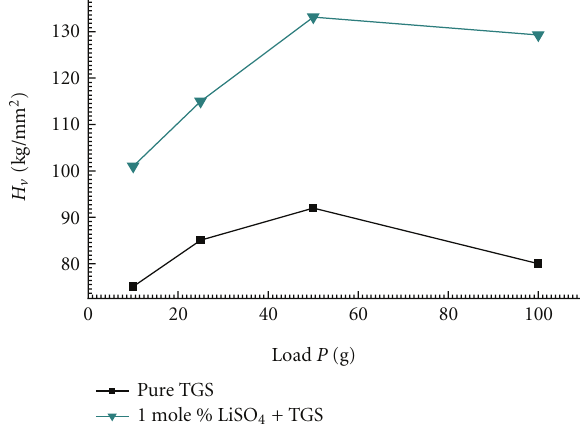
Figure 3: D.C. electrical conductivity for pure and LiSO 4 -doped TGS crystals.